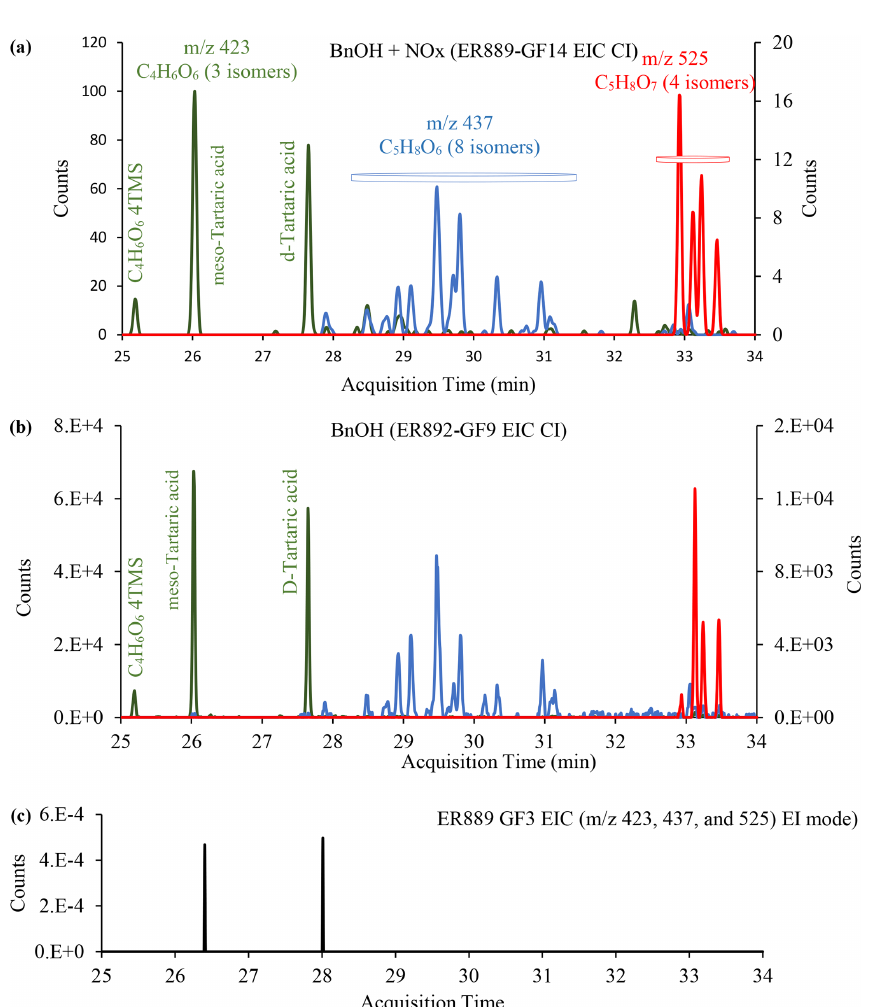
Figure 4. Portion (25–34min) of GC-MS extracted ion chromatograms (CI–CH 4 ) at m/z 423 (green), m/z 437 (blue), and m/z 525 (red) merged in one chromatogram: (a) BnOH in the presence of NO x ; (b) BnOH in the presence of H 2 O 2 and absence of NO x . (c) Chamber background. Red and top blue: right